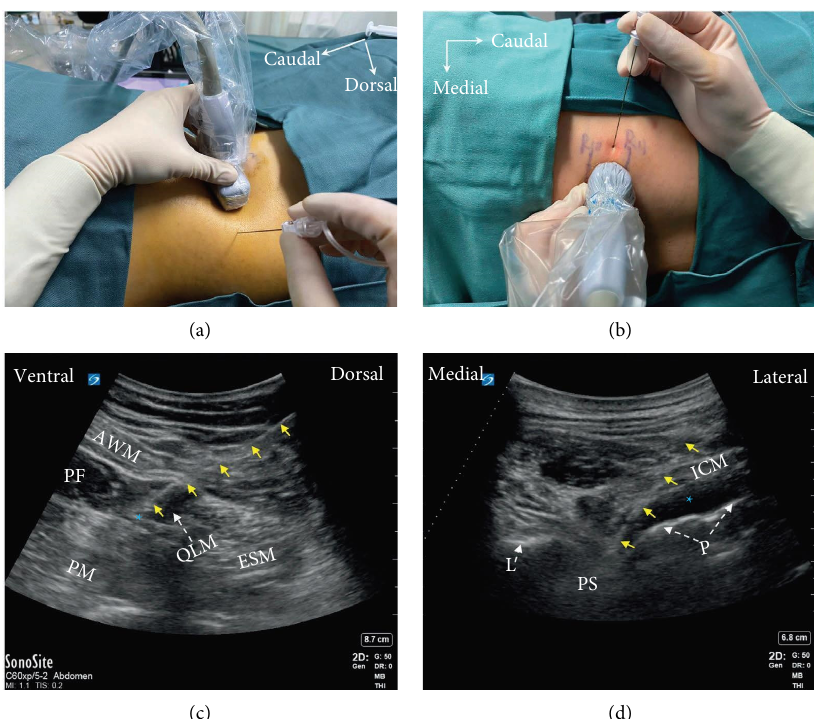
Figure 1: Ultrasound-guided transmuscular quadratus lumborum block (a, b) and thoracic paravertebral block (c, d). AWM: abdominal wall muscle, EPF: extraperitoneal fat, ESM: erector spine muscle, PM: psoas muscle, QLM: quadratus lumborum muscle, P: pleura, PS: paravertebral space, L: lamina, ICM: intercostal muscle, ∗ : LA, yellow arrows: